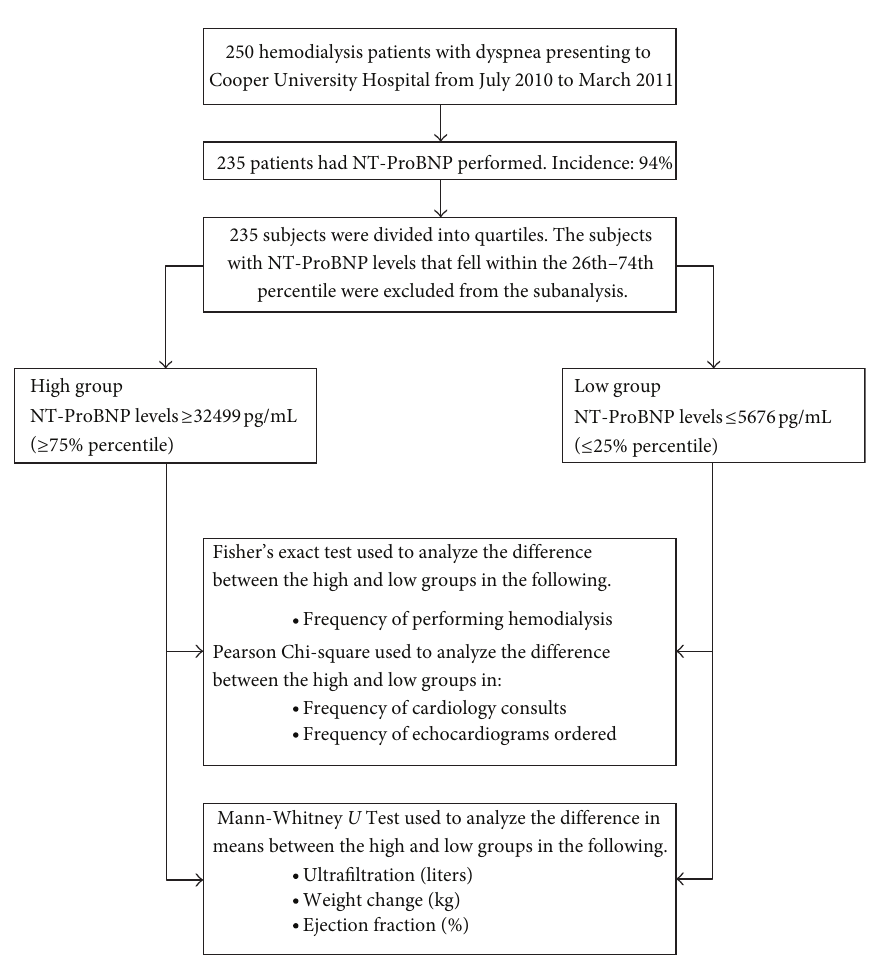
Figure 2: Subject selection of extreme